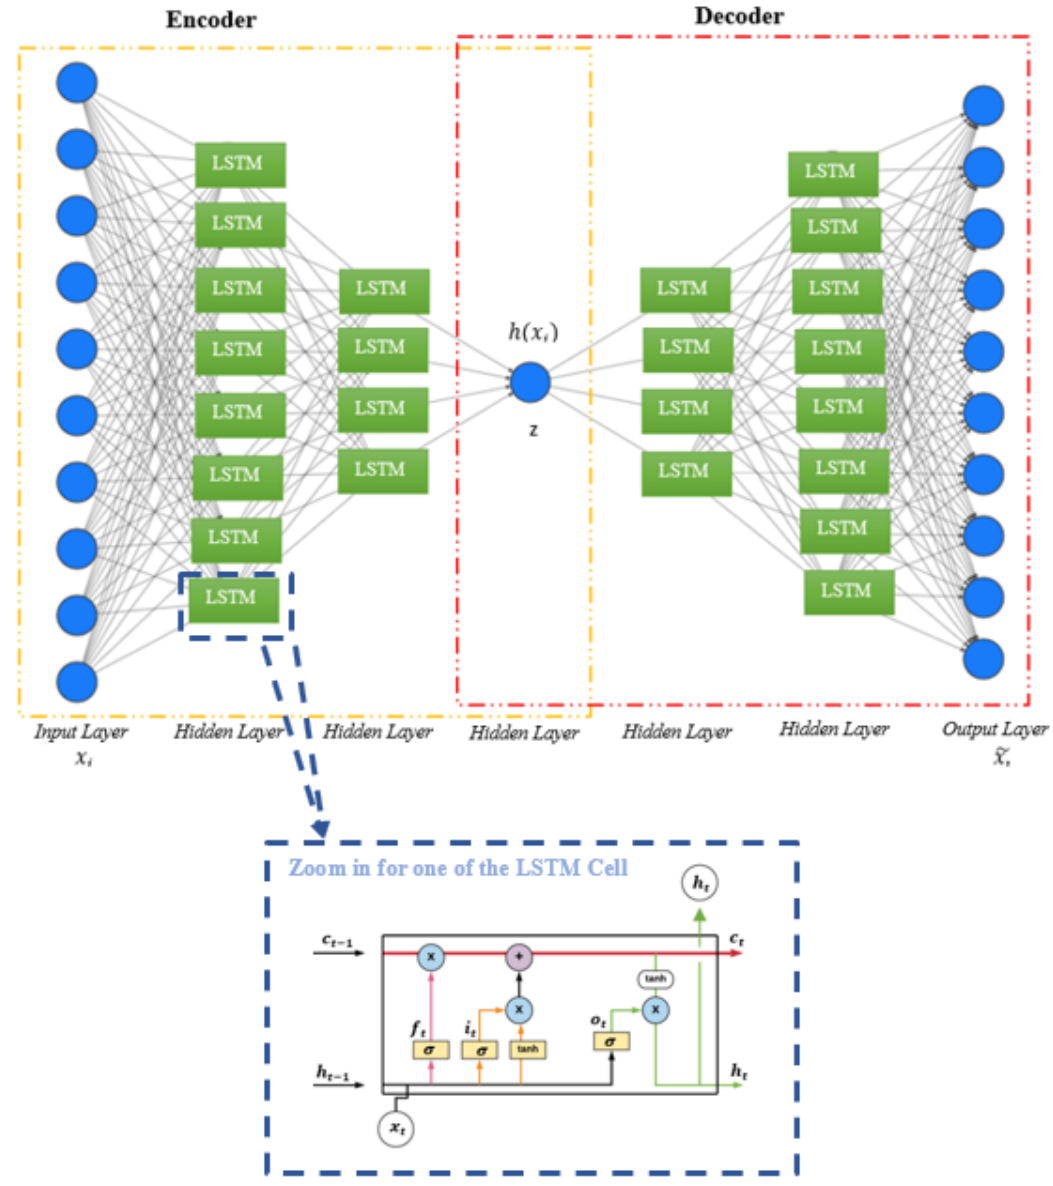
Figure 19. LSTM Autoencoder architecture.